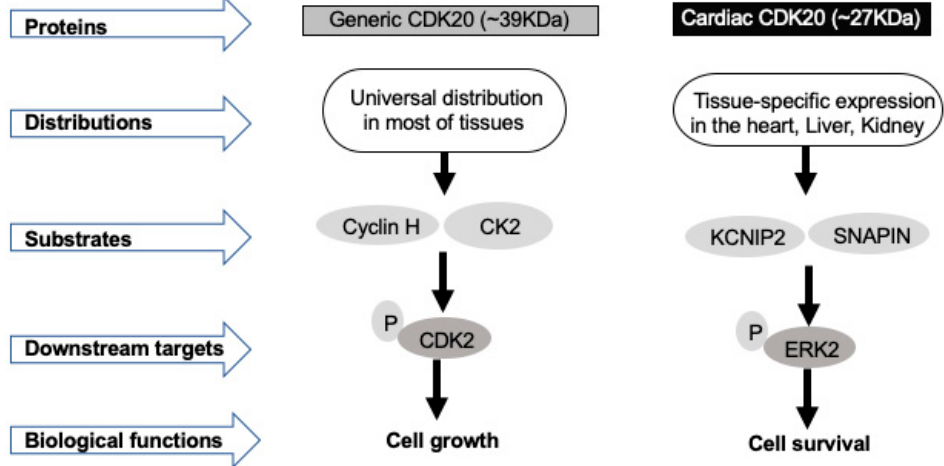
Figure 2. Difference of two variants of CDK20. Generic CDK20 and cardiac CDK20 are the two isoforms of CDK20 with differences in tissue distributions, substrates, downstream targets, and biological functions. While generic CDK20 widely expresses in most tissues and acts as a cell cycle regulator to promote cell growth, cardiac CDK20 expresses predominantly in the heart, liver, and kidney, and promotes the cell survival pathway.